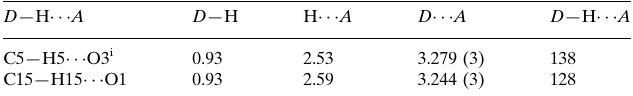
Hydrogen-bond geometry (A˚ , (cid:1)